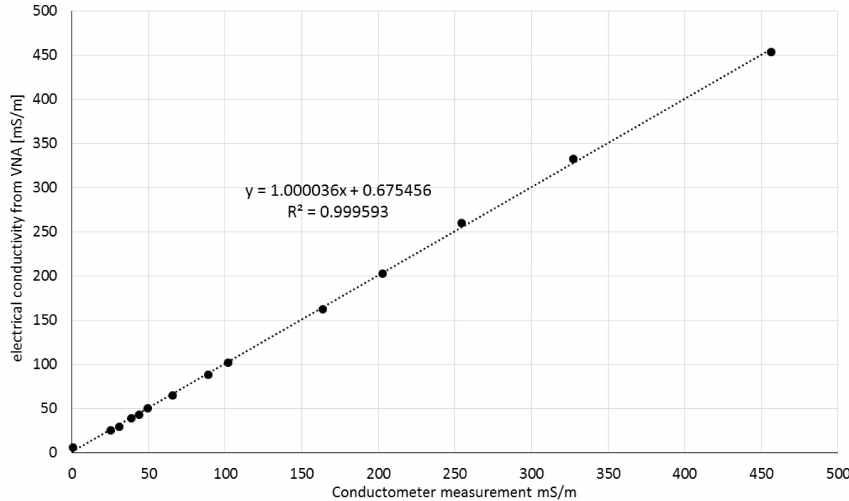
Figure 11. The electrical conductivity values of the VNA-measured solutions, obtained using Equation (3), with respect to the actual electrical conductivity of the solutions measured using a laboratory conductometer.